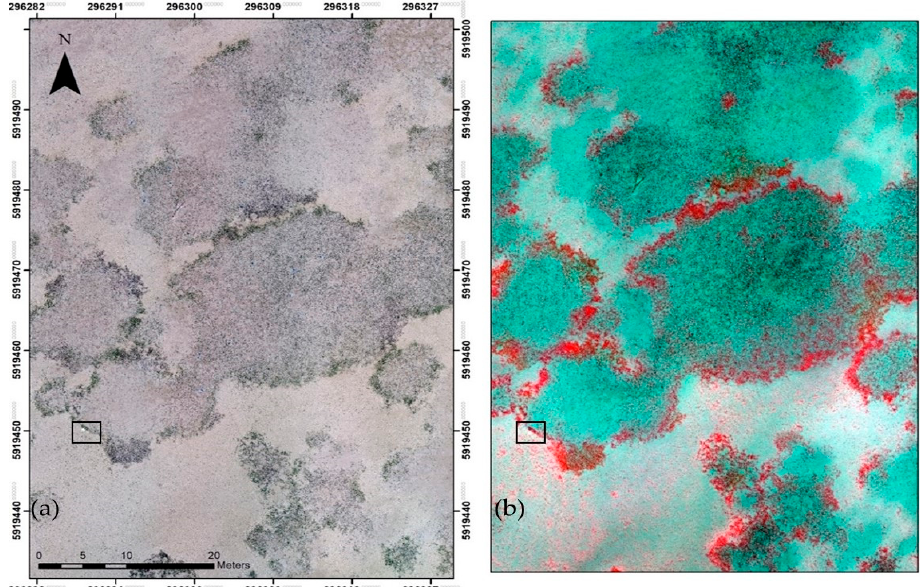
Figure 2. ( a ) VIS true-color image composite and ( b ) VIS+NIR false-color image composite. The black square in both imageries reveals one of the ground control points from the ten used for geometric correction.